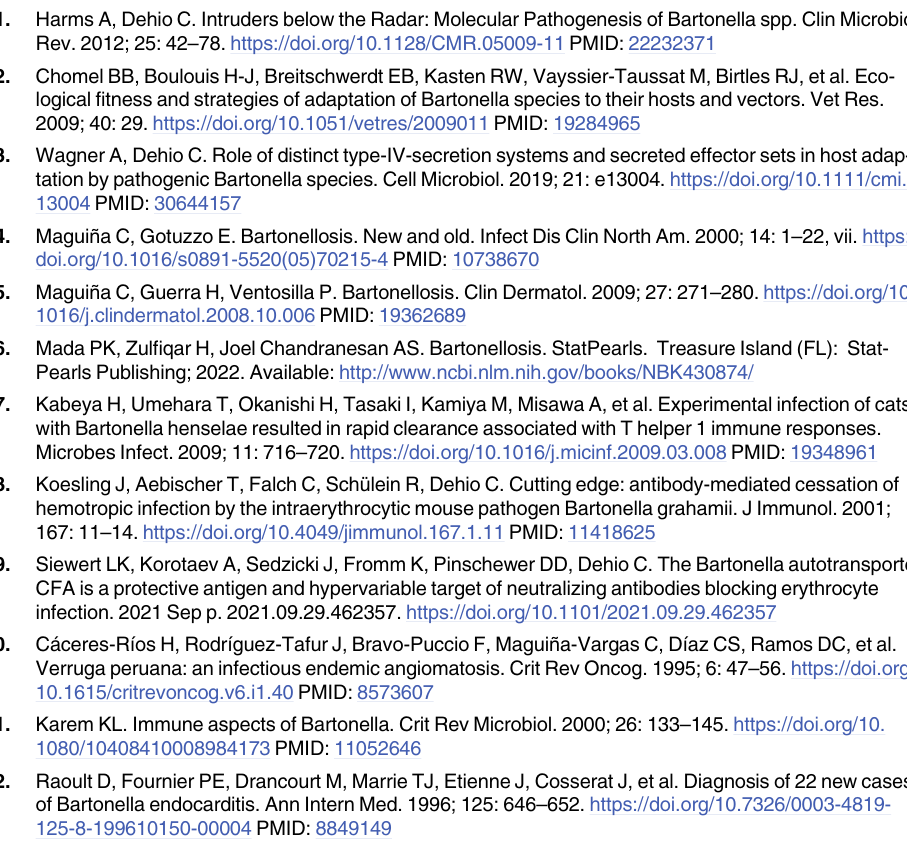
three mice per group. (C-E) Each symbol represents an individual litter, horizontal lines and error bars depict the mean ± SD. Statistical analysis was performed by unpaired Student’s t- test, with P-values indicated in the figure. S1 Table. Raw data table. Excel spreadsheet containing, in separate sheets, the underlying numerical data and statistical analysis for Fig panels 1B, 1C, 2B-F, 3B-D, 3F and 4G and